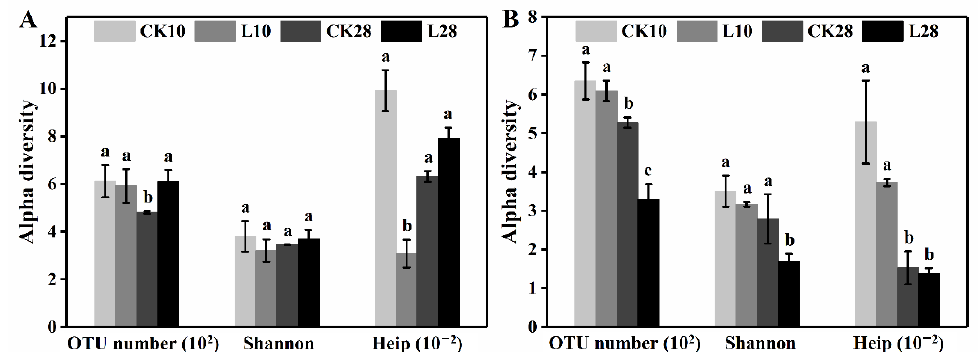
Figure 2. Alpha diversity changes of the bacterial ( A ) and fungal ( B ) community in the phyllosphere during the low-level ozone exposure. OTU number, Shannon and Heip are three estimators listed with error bars representing standard deviation ( n = 3). Different letters indicate significant differences (LSD test, p < 0.05).